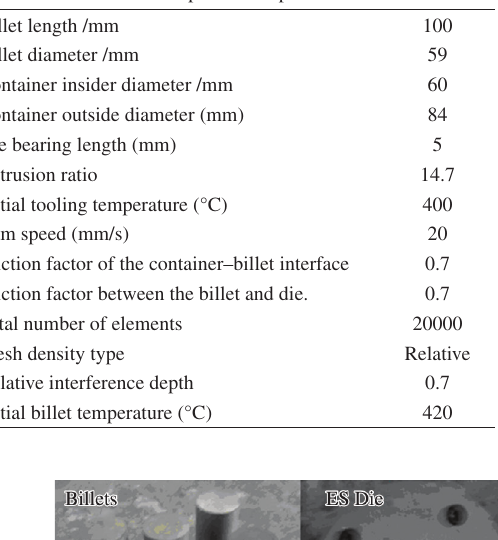
Figure 2. True stress/true strain curves obtained from the compression tests with pre-set temperature 400°C and the different strain rates 0.01s –1 -10s –1 . Table 2. Simulation and experimental parameters.